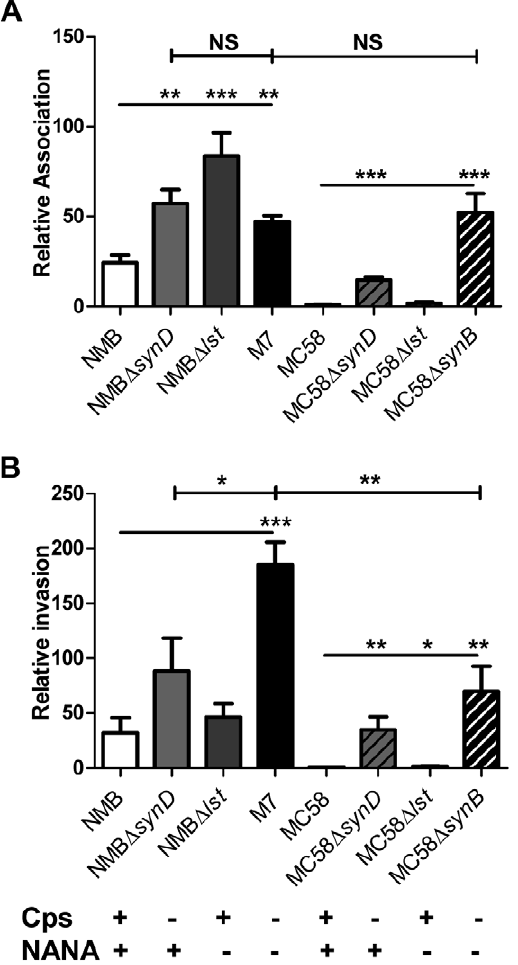
Figure 4. The effect of capsule and total sialic acid on attachment and invasion of strains NMB-CDC and MC58. Panel A and B show the rates of association and invasion, respectively, of capsule and sialic acid mutants relative to strain MC58. Parental wild- type (white bars), capsule mutants ( D synD , light grey bars), LOS sialylation mutants ( D lst , dark grey bars) and sialic acid mutants ( D synB , black bars) in strain NMB-CDC (solid) and MC58 (diagonally stripes bars) are shown. The rate of association and invasion was determined by viable counts following 6 hr co-incubation. The relative rate of association of each strain was normalised to strain MC58 (value of 1) and values were plotted as the average fold change ( + / 2 SEM). *: p , 0.05, **:p , 0.005, ***:p , 0.0001 as determined by Mann-Whitney t- test).